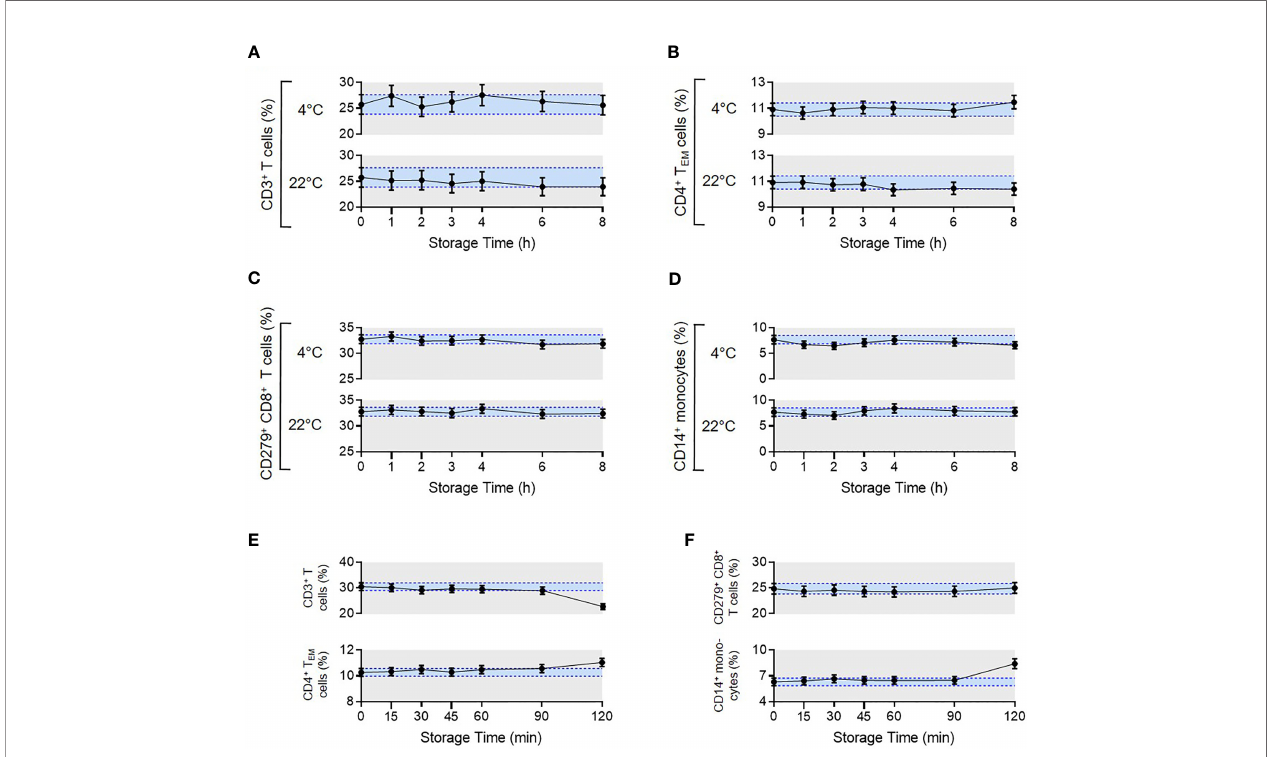
FIGURE 5 | Pre- and post-analytical stability of the MoT test. To evaluate pre-analytical stability, whole blood EDTA samples from n = 4 healthy donors were either stored at 4°C in the dark in the fridge or light exposed at room temperature. Processing the samples started either directly after blood draw (0 h) or delayed in time (1-8 h). Acquired fl ow cytometry data were analyzed and frequencies of CD3 + T cells (A) , CD4 + T EM cells (B), CD279 + CD8 + T cells (C) and CD14 + monocytes (D) were determined. Mean CVs of intra-assay precision were used for calculation of SDs. Results are displayed as mean with 95% CI. For the analysis of post-analytical stability, acquisition of fully processed blood samples from healthy donors (n = 3 for CD279 + CD8 + T cells, n = 6 for all other reporters) started either immediately after staining or delayed in time (15-120 min). (E, F) Frequencies of CD3 + T cells, CD4 + T EM cells, CD279 + CD8 + T cells and CD14 + monocytes were determined. Mean CVs of intra-assay precision were used for calculation of SDs. Results are displayed as mean with 95%